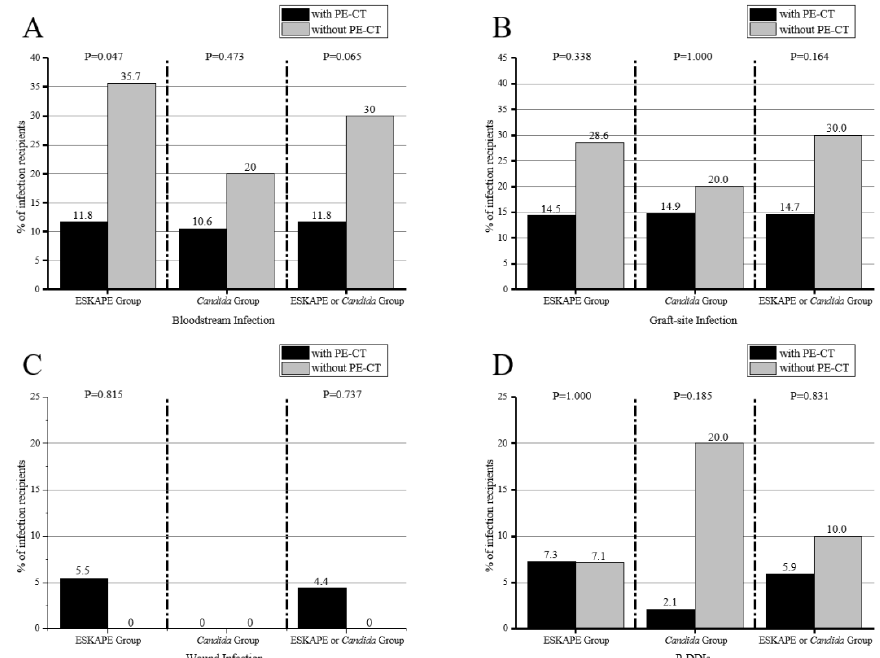
Figure 3. The effect of preemptive antibiotic therapy (PE-T) of preservation fluid pathogens in early infection-related events after kidney transplantation. Effect of PE-T on bloodstream infection between the ESKAPE group, Candida group, and ESKAPE or Candida group ( A ). Effect of PE-T on graft-site infection between the ESKAPE group, Candida group, and ESKAPE or Candida group ( B ). Effect of PE-T on wound infection between the ESKAPE group, Candida group, and ESKAPE or Candida group ( C ). Effect of PE-T on P-DDIs between the ESKAPE group, Candida group, and ESKAPE or Candida group ( D ).